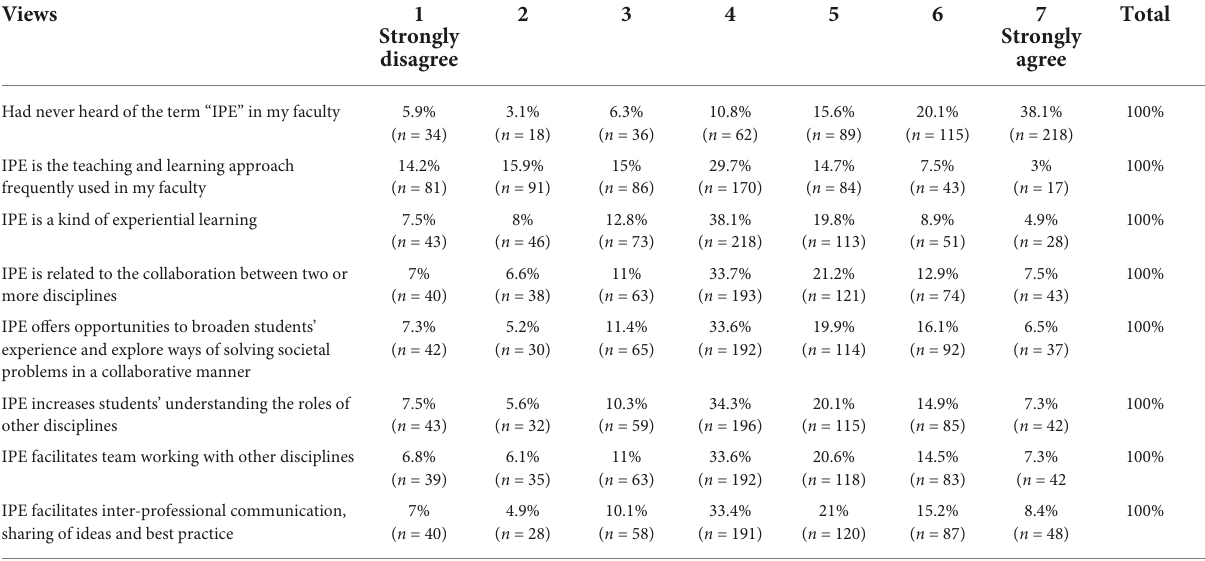
TABLE 1 Understanding and perception of interprofessional education (students).